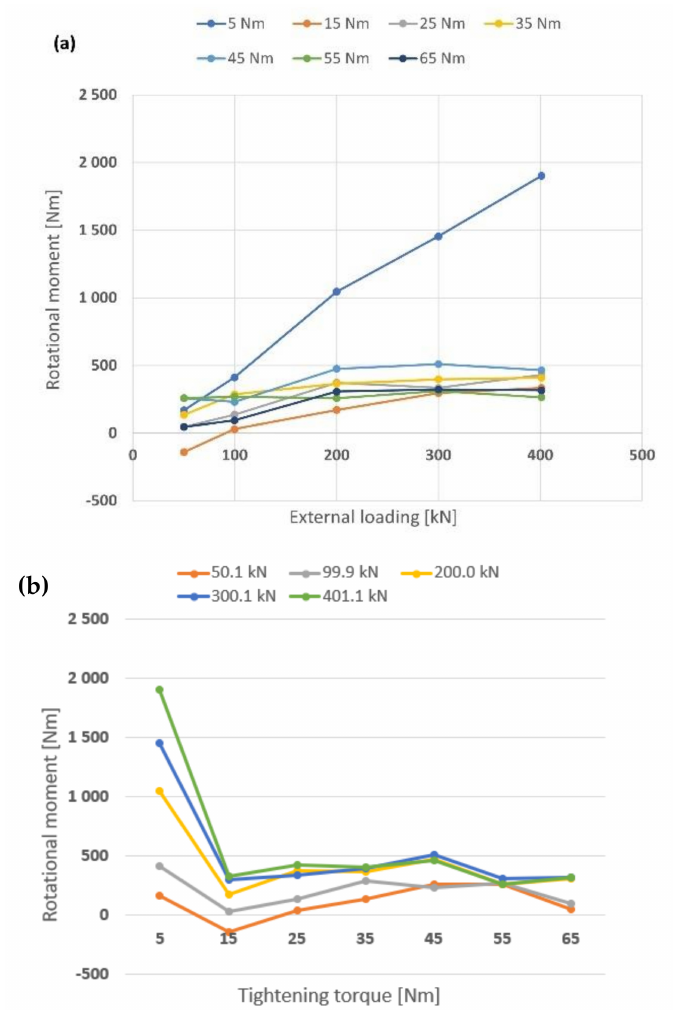
Figure 15. Test 2b—Total rotation moment per bearing with bearing on double sleeves with ( a ) increasing external load and ( b ) increasing torque